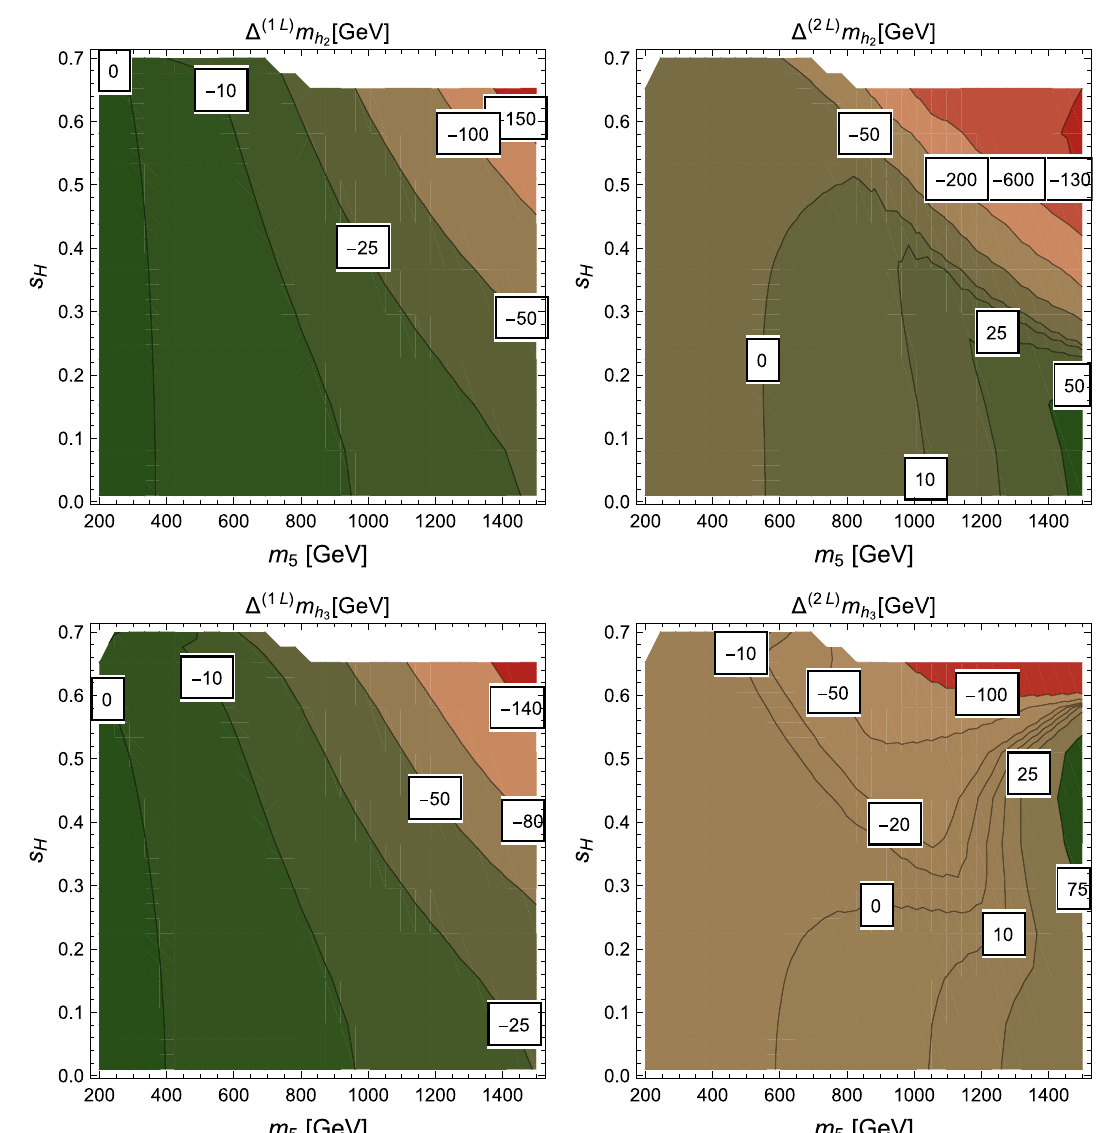
Fig. 12 The size of the one- (left) and two-loop (right) corrections in the ( s H , m 5 ) plane for the second (first row) and third (second row) CP-even